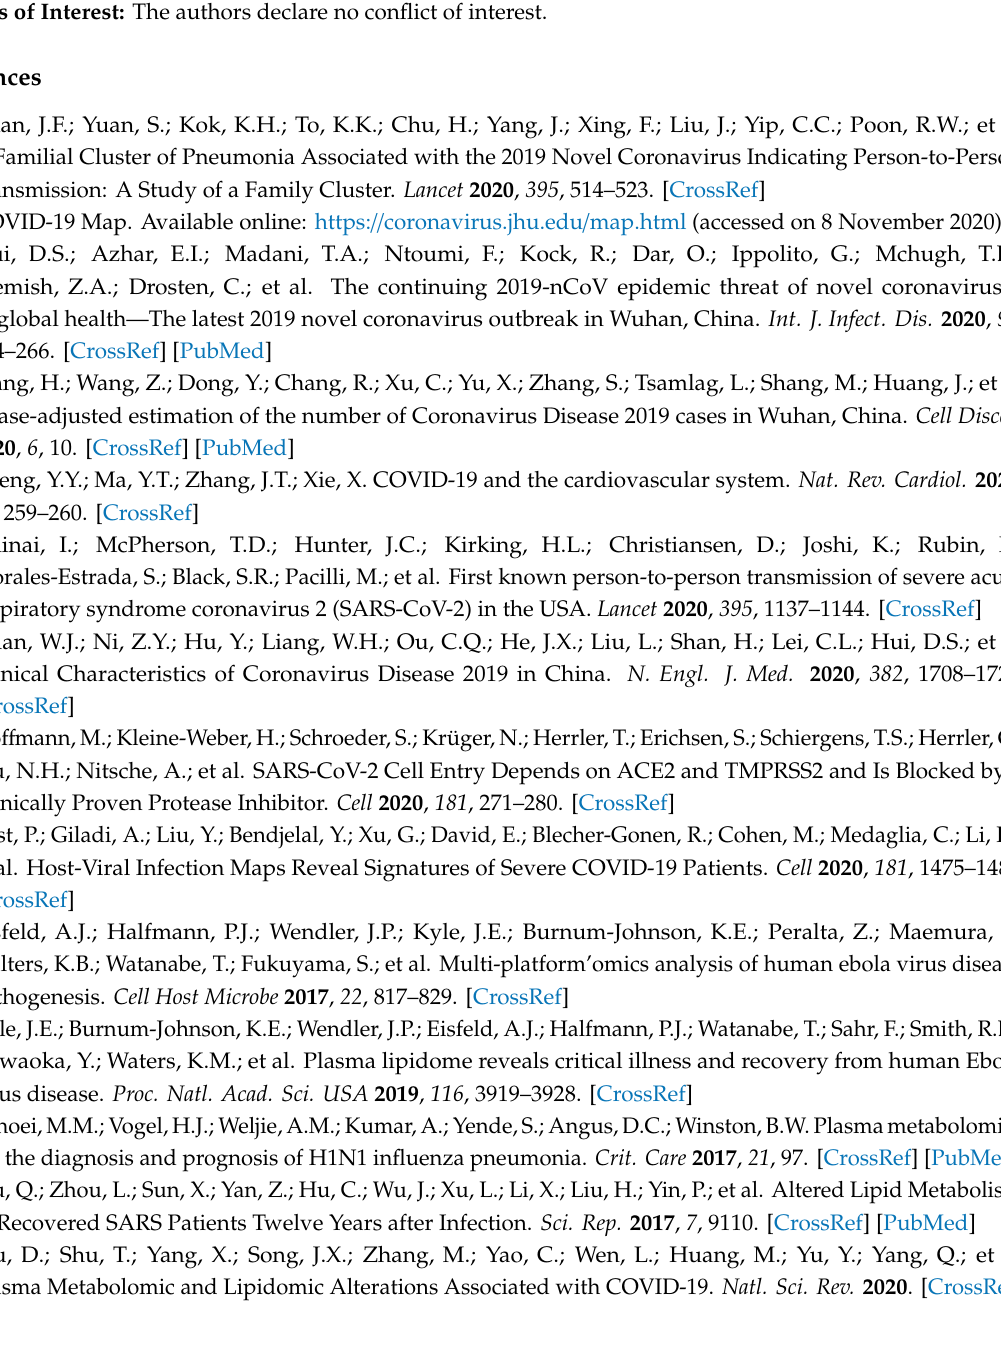
Table S4. RSDs of internal standards in QC samples of metabolomics